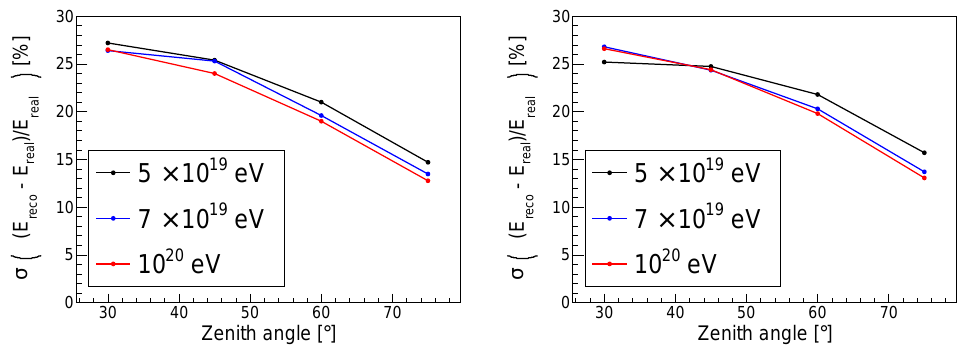
Figure 14. Estimates of energy reconstruction for different energies and zenith angles. ( Left ): center of the field of view. ( Right ): full field of view of the